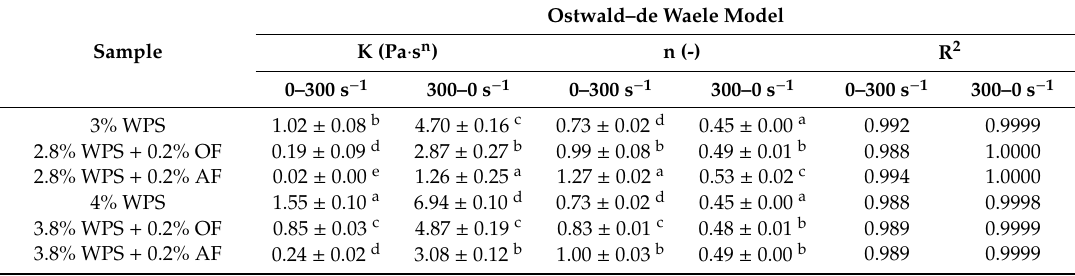
Table 2. Parameters of steady flow measurements of starch pastes and their mixtures with dietary plant